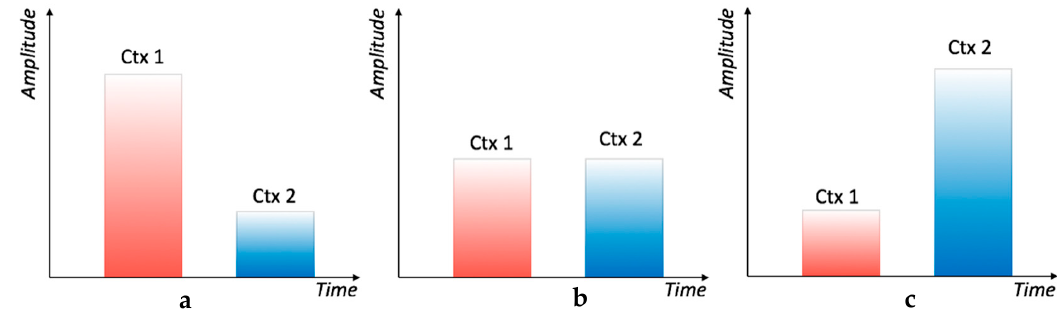
Figure 5. Comparison between the signals: ( a ) athlete position close to the left wire; ( b ) athlete in the central position (secure zone); and ( c ) athlete position close to the right wire.